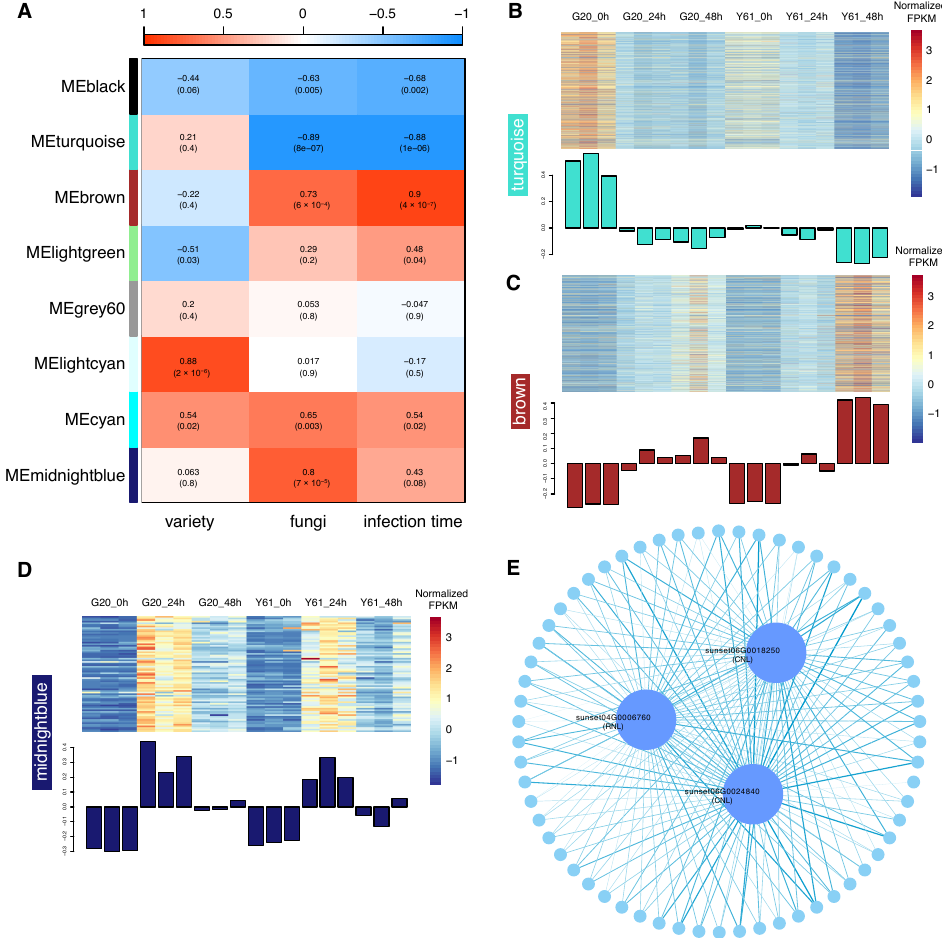
Figure 9. Gene co-expression network analysis of NLRs in papaya. ( A ) Correlation of gene modules and traits. ( B – D ) Eigengene and total gene expression of turquoise, brown, and midnightblue modules. ( E ) Gene co-expression network of three NLRs in the midnightblue